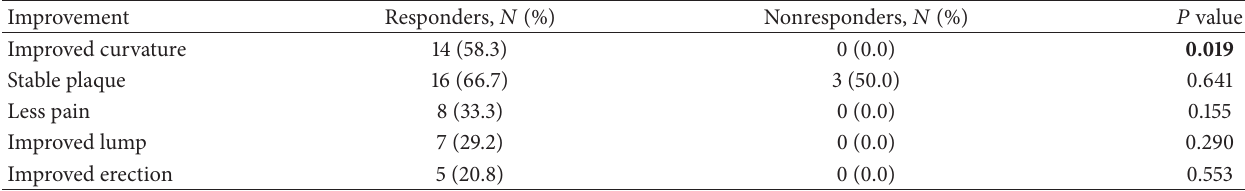
Table 6: Beneficial changes reported by patients following